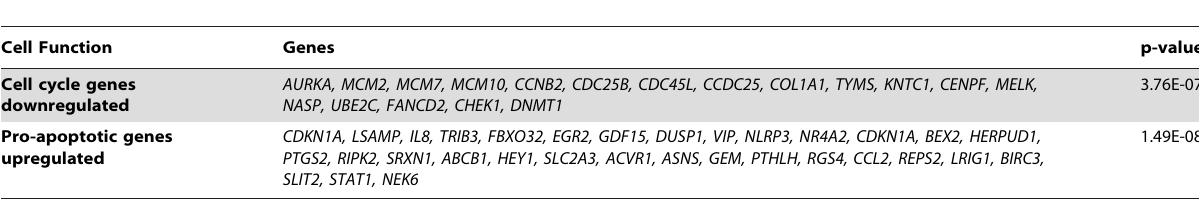
Table 1. List of differentially expressed genes in 5-AzadC and 4-PBA treated Saos2 cells.